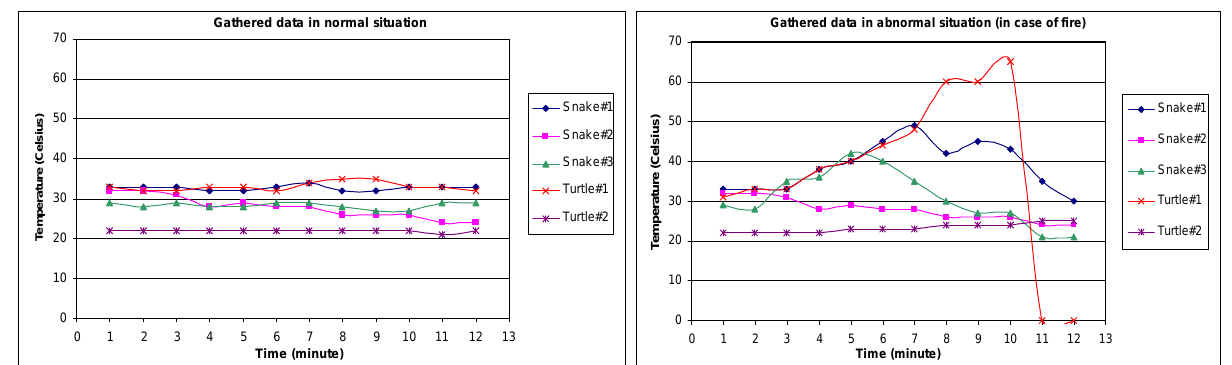
Figure 7. Data gathered from MBSs under both normal and abnormal (fire)